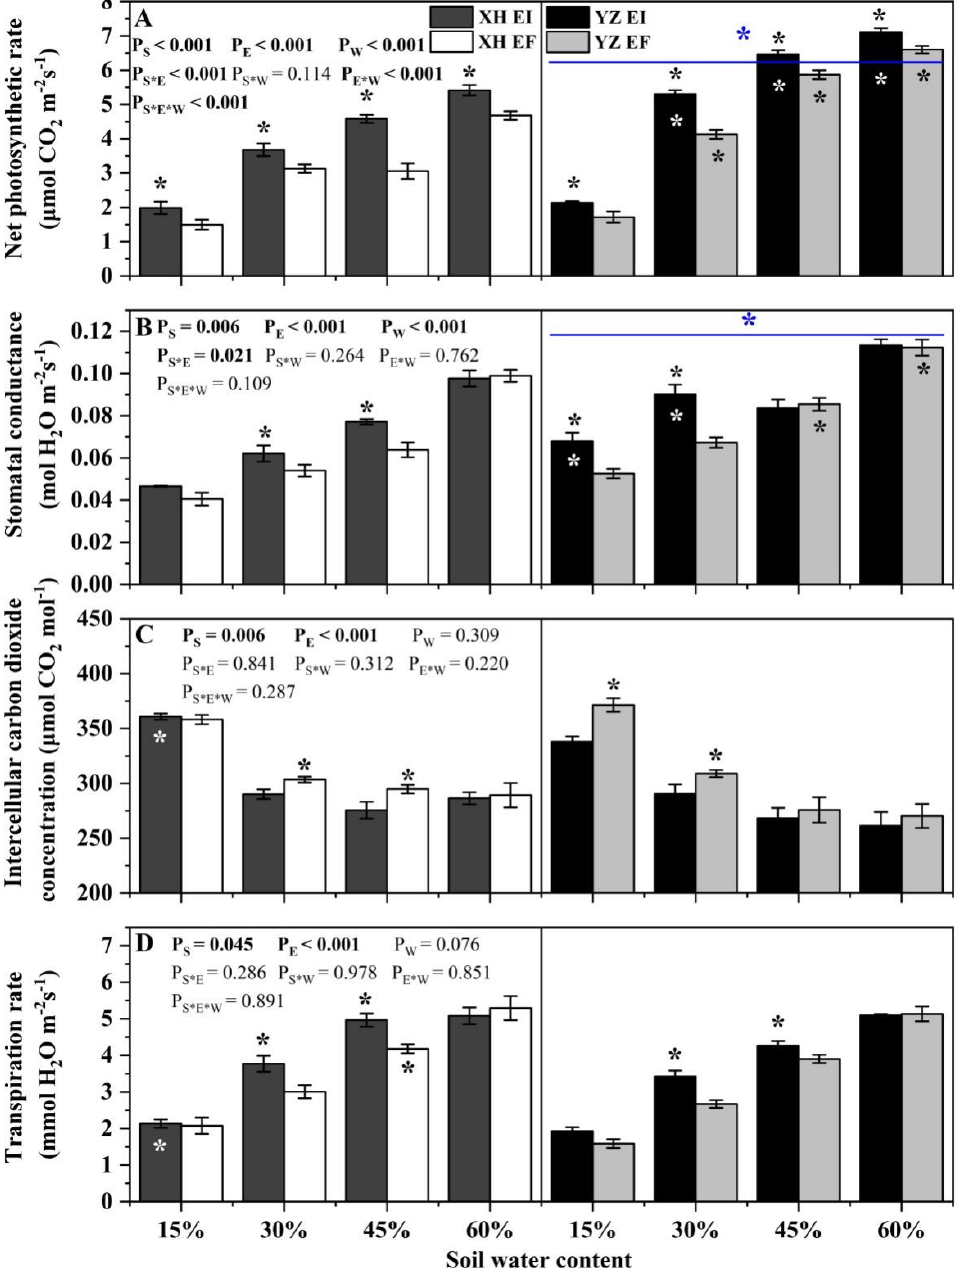
Figure 6. The photosynthetic parameters of A. inebrians seedlings shoots from XH(W) and YZ(D) seeds under various soil water content. ( A ) Net photosynthetic rate ( µ mol CO 2 m − 2 s − 1 ), ( B ) Stomatal conductance (mol H 2 O m − 2 s − 1 ), ( C ) Intercellular carbon dioxide concentration ( µ mol CO 2 mol − 1 ), ( D ) Transpiration rate (mmol H 2 O m − 2 s − 1 ). The asterisk (*) above error bars means significant difference ( p < 0.05) between EI and EF under the same soil water content. White/black * in the dark gray, black and gray bars indicates significant difference ( p < 0.05) between Xiahe and Yuzhong maternal habitat type of EF/EI grasses. The blue * above/below full blue line indicates significant difference ( p < 0.05) between Xiahe and Yuzhong maternal habitat type.